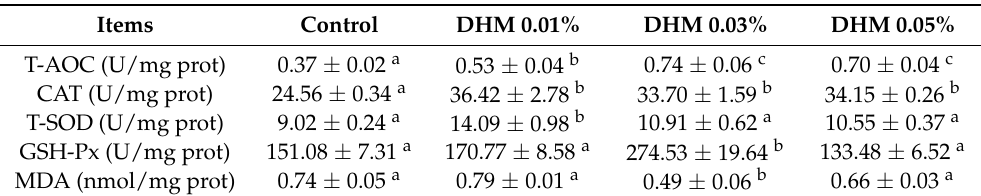
Table 1. Effects of dietary DHM supplementation on antioxidant indicators in jejunum mucosal of growing-finishing pigs.